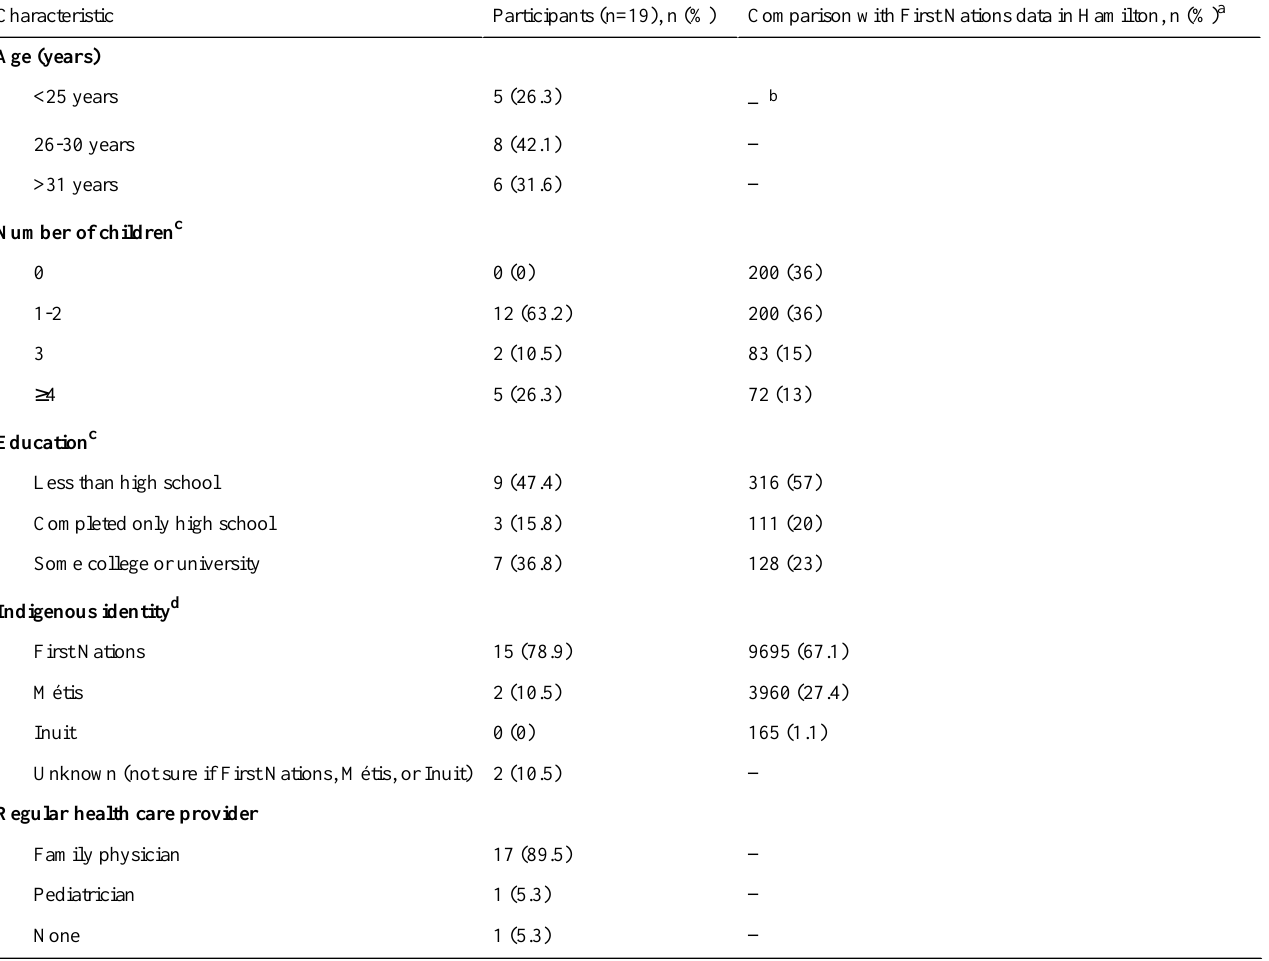
Table 1. Demographic information: participant